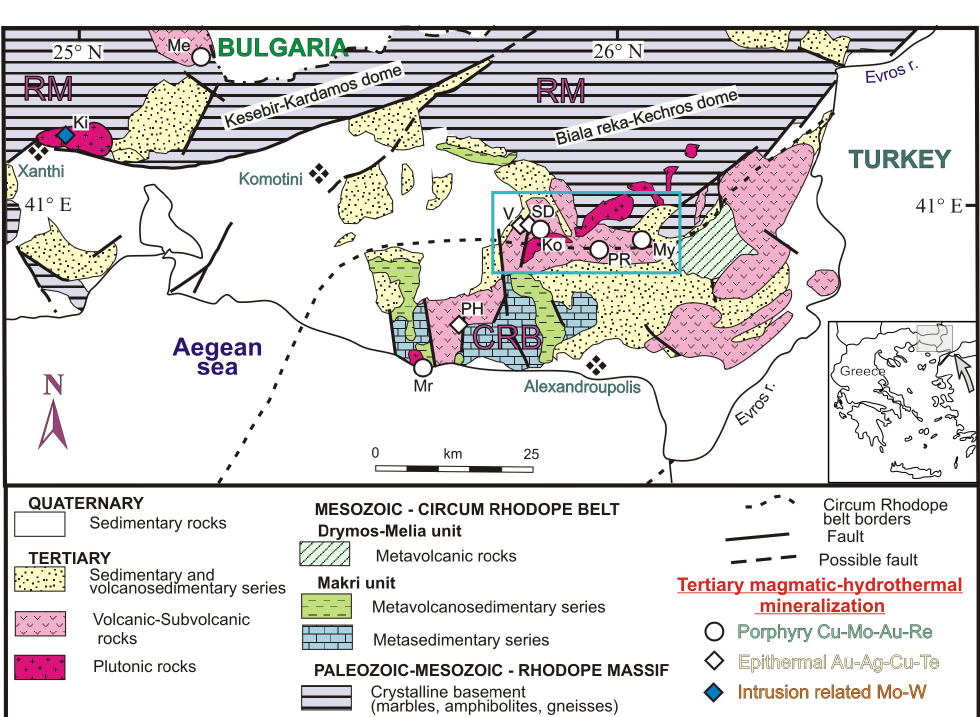
Figure 2. Simplified geological map of the southeastern part of the Rhodope Massif and location of major porphyry Cu–Mo–Au and epithermal Cu–Au–Ag–Te deposits (after [39]). Abbreviations: Me = Melitena; Mr = Maronia; Ki = Kimmeria; PH = Perama Hill; Ko = Konos; SD = St Demetrios; V = Viper; PR = Pagoni Rachi; My = Myli. Sapes–Kirki–Esymi area (blue square). Abbreviations: RM = Rhodope Massif, CRB = Circum–Rhodope